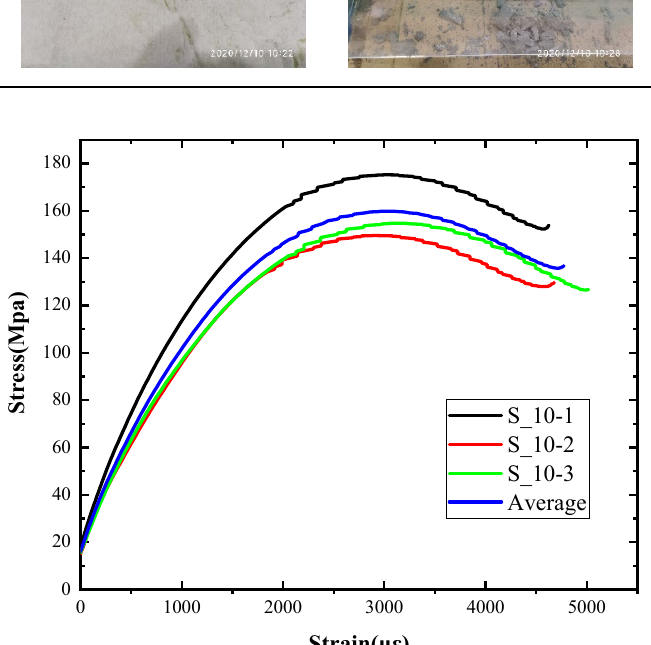
Figure 6. Stress–strain curve of 10 m/s.